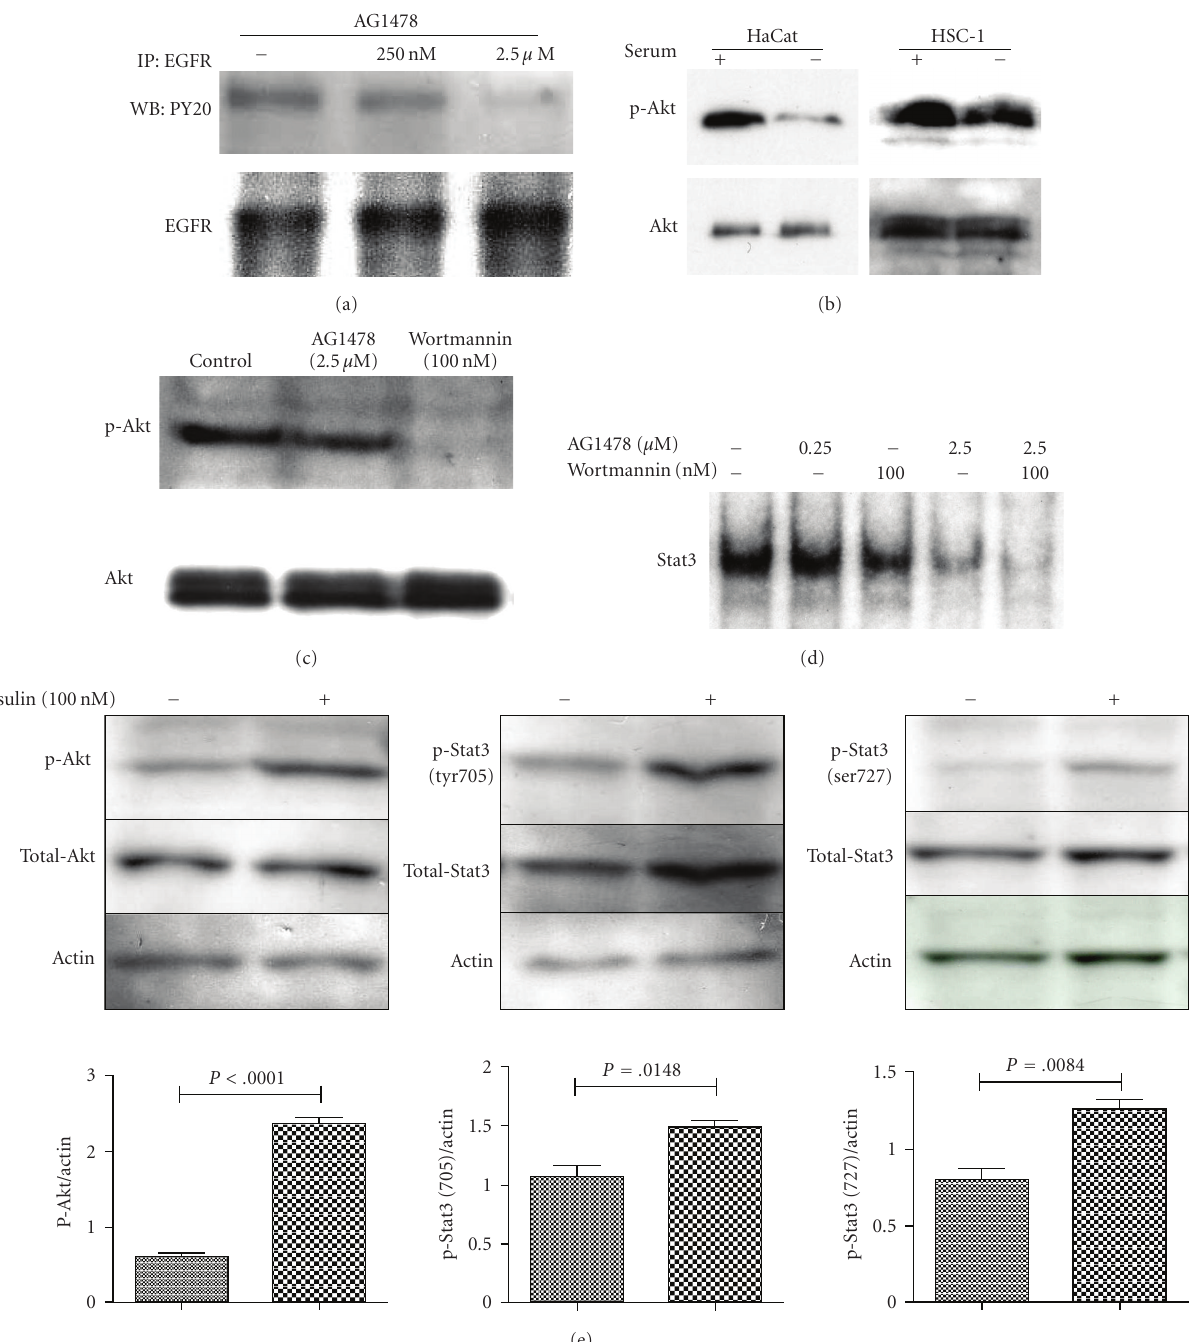
Figure 4: E ff ect of wortmannin, AG1478, and insulin on activation of Stat3 and Akt in HSC-1 cells. HSC-1 cells were incubated in serum free medium for 24 h, and were then treated with AG1478 at the indicated concentration for 1h. The cell lysates were subjected to IP with the anti-EGFR antibody. The same membrane was then reprobed with the anti-EGFR antibody (a). The cells were incubated with or without serum for 24 h, and then each lysate was immunoblotted with anti-p-Akt antibody, and then reprobed with the anti-Akt antibody (b). HSC- 1 cells were incubated in serum free medium for 24h, and were then treated with AG1478 or wortmannin for 1h. The cell lysates were immunoblotted with the anti-p-Akt antibody, and then reprobed with the anti-Akt antibody (c). HSC-1 cells were incubated in serum free medium for 24 h, and were then treated with AG1478 and/or wortmannin at the indicated concentration for 1h. DNA binding activity of Stat3 was analyzed using EMSA (d). HSC-1 cells were incubated without serum for 24h, and were then treated with or without insulin for 15 min. The cell lysates were immunoblotted with each of the anti-p-Akt or p-Stat3 antibody and then reblotted with human actin as a loading control. The same membrane was reprobed with the anti-Stat3 or Akt antibody (e). The bar graphs are expressed as the relative ratio of p-Akt or Stat3 protein expression to actin protein expression by densitometry. Data are mean ± SD of three independent experiments. P < . 05 are statistically significant when compared with the non-treated control